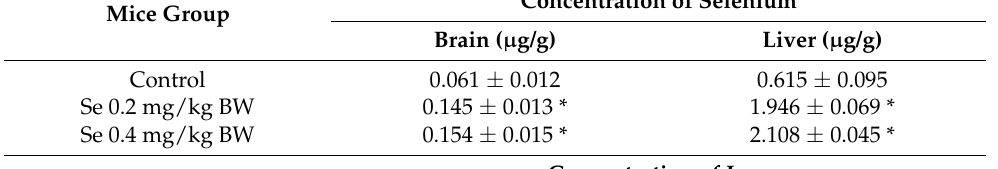
Table 1. Concentrations of selenium and iron in the brain and liver of control group mice and mice orally treated with a Na 2 SeO 3 solution for 8 weeks. The model of selenium exposure to mice is described in the Methods section. Data represent the results of eight separate experiments. Results are expressed as the mean ± SEM. *—differences are statistically significant in comparison to the control group; p < 0.05. Concentration of Selenium Mice Group Brain ( µ g/g) Liver ( µ g/g) Control 0.061 ±